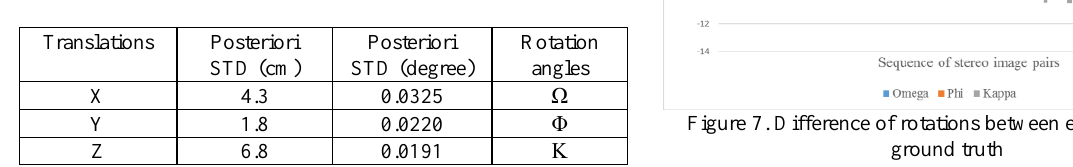
Table 2. RMS of posteriori STDs of ego-motion